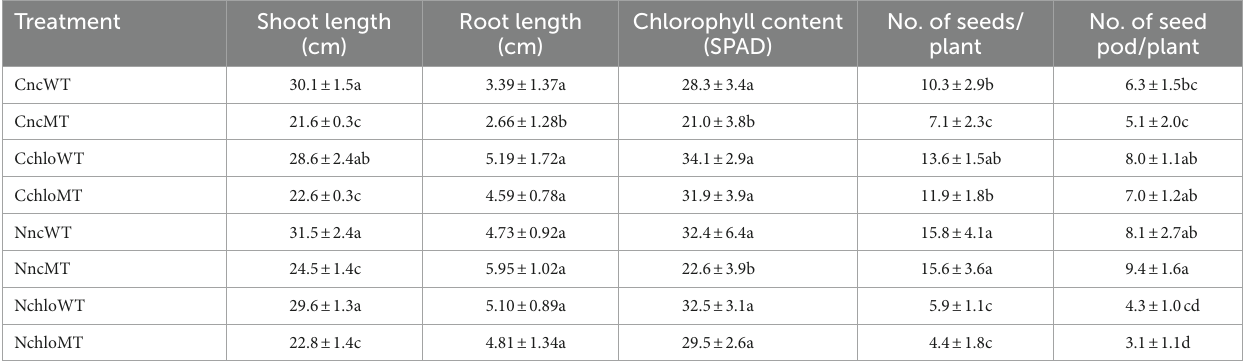
TABLE 1 Growth characteristics of Glycine max cv. Enrei (wild-type) and En1282 (non-nodulating mutant) grown under fumigated and non-fumigated nature and conventional farming systems. Treatment